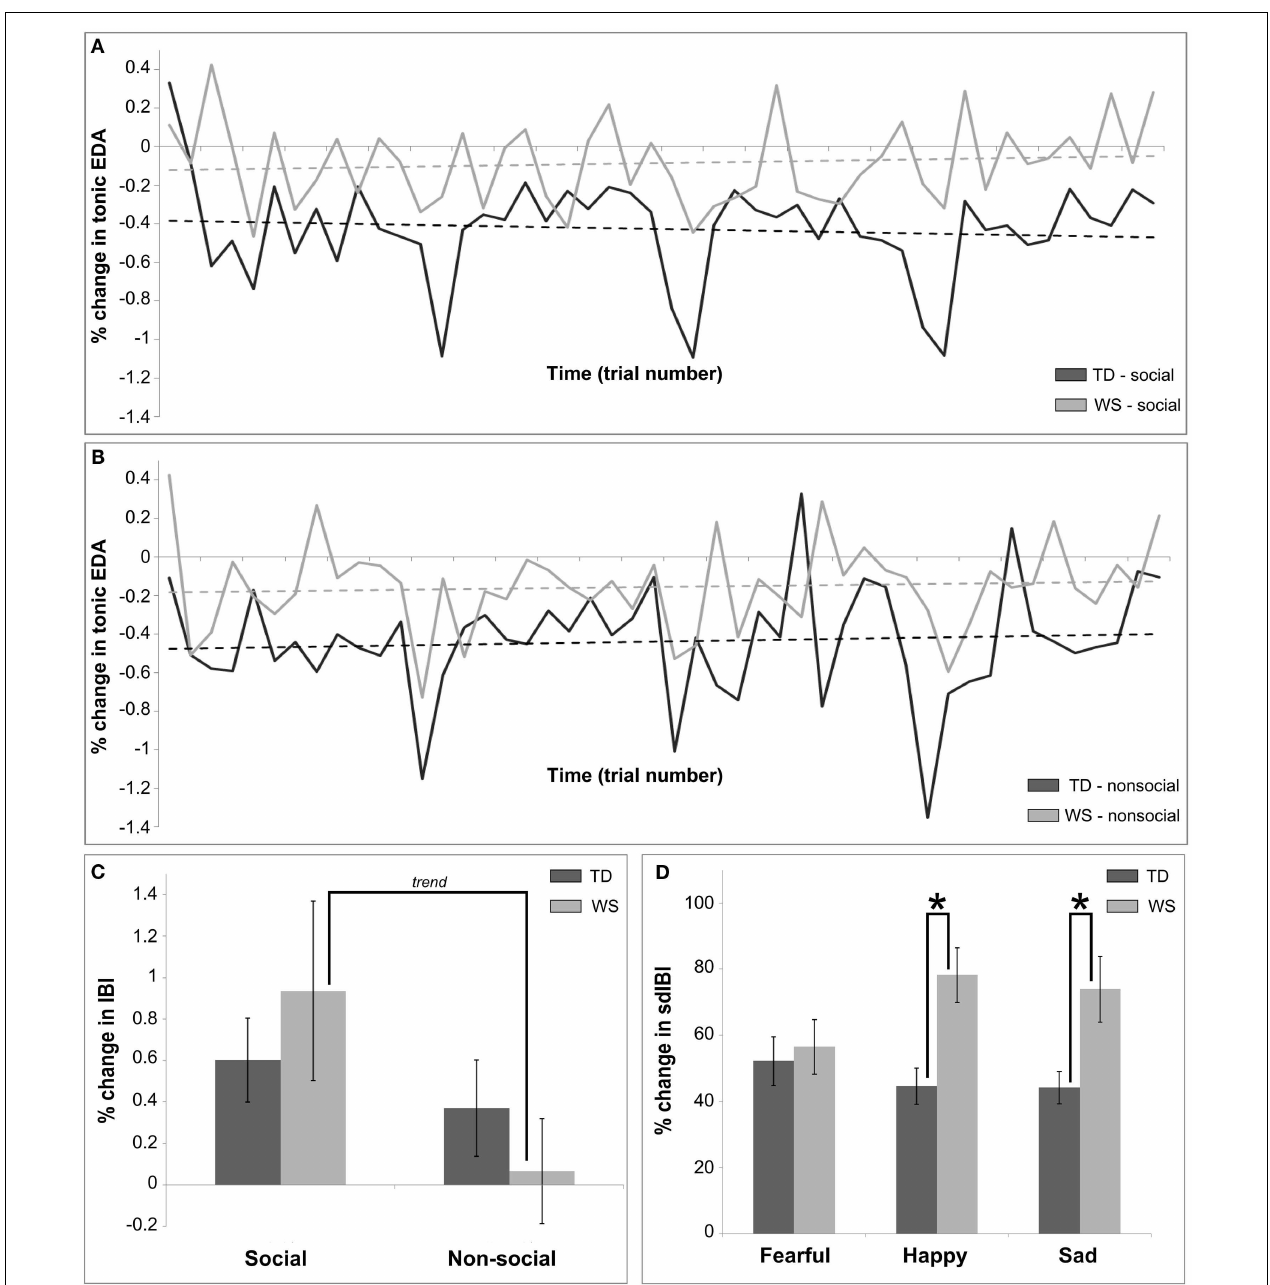
percentage change between baseline and post stimulus in the mean tonic EDA. (C) Presents the differences between social and non-social conditions in TD andWS participants, calculated as a percentage change between baseline and post stimulus in the mean IBI. (D) Displays differences between affective stimuli inTD andWS participants, calculated as a percentage change between baseline and post stimulus in the